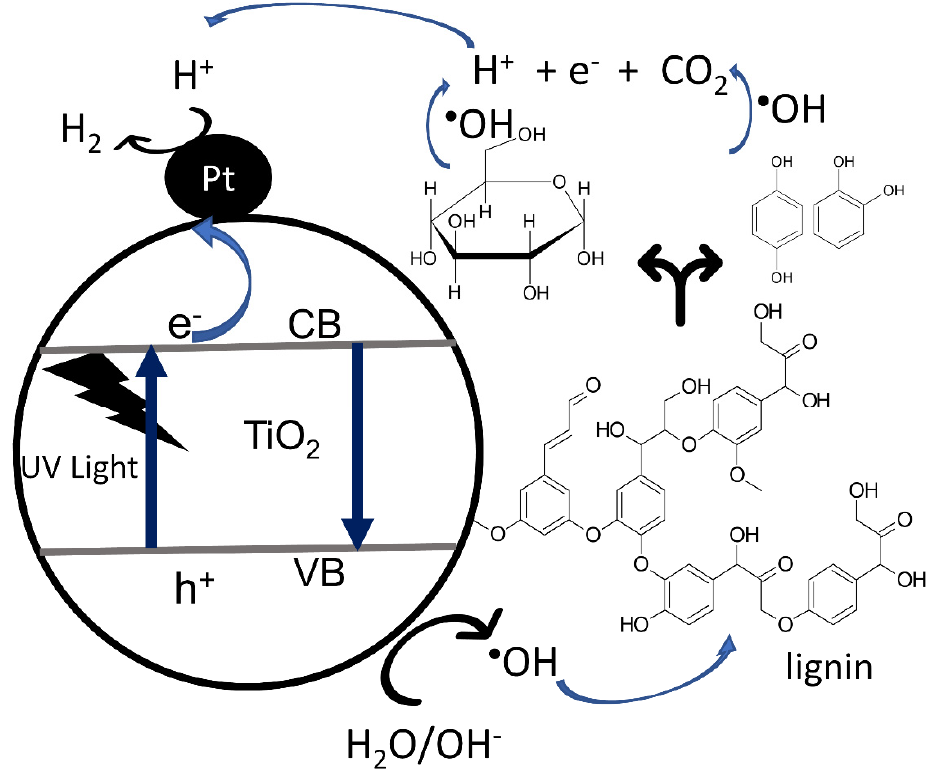
Figure 5. Lignin photo-reforming process directly attacks lignin’s phenyl rings, forming catechol and hydroquinone [87].